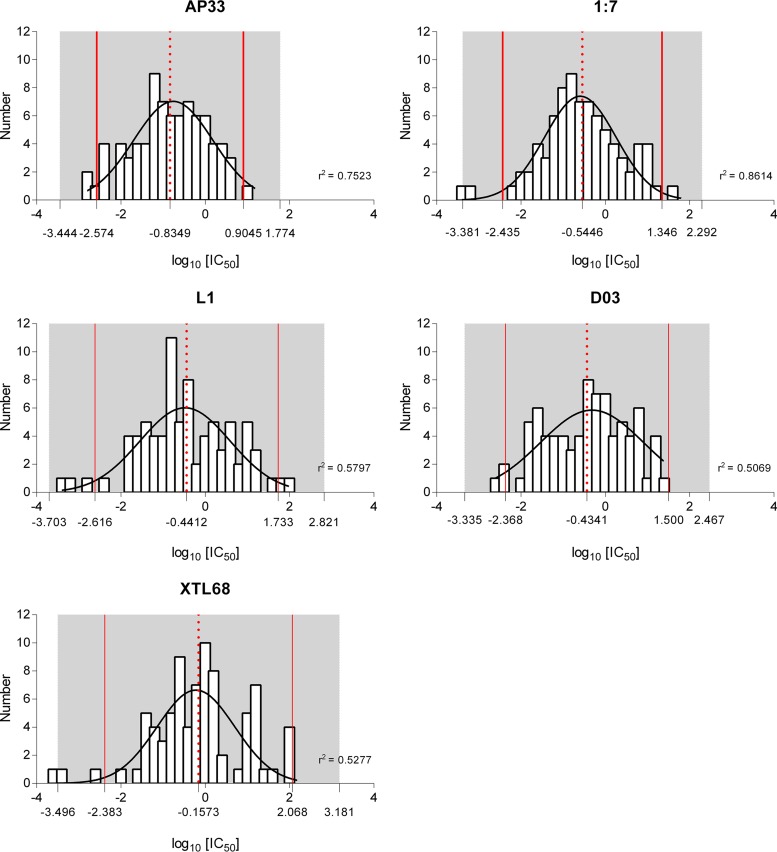
Normally distributed IC50s for each antibody. Shown are frequency distribution plots of log10 IC50s, and the derived Gaussian curves, from all 81 clones for MAbs AP33, 1:7, L1, and XTL68 and nB D03. The mean log10 IC50 for each antibody is represented by a red dashed line, the mean ± 2 standard deviations by solid red lines, and the mean ± 3 standard deviations by gray shading. Each plot fit a normal distribution curve, as shown by the D'Agostino and Pearson omnibus normality test.